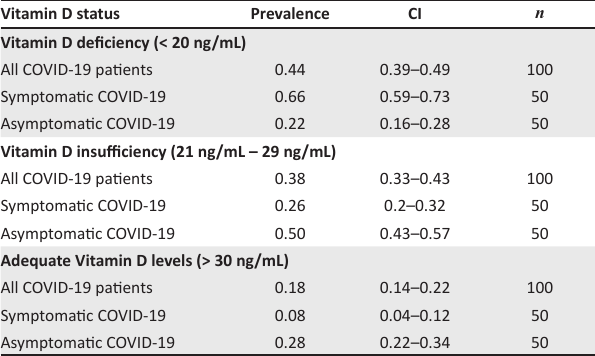
TABLE 1: The prevalence of Vitamin D deficiency and Vitamin D